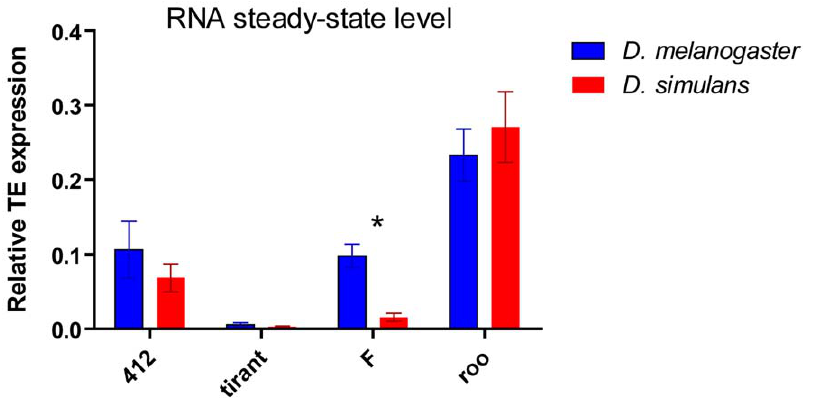
Figure 4. Expression of transposable element families in D.melanogaster (blue) and D.simulans (red). Mann Whitney P-values are shown with asterisks (p-value * , 0.05).